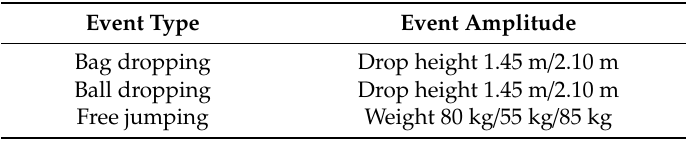
Table 6. Data structure of benchmark database.